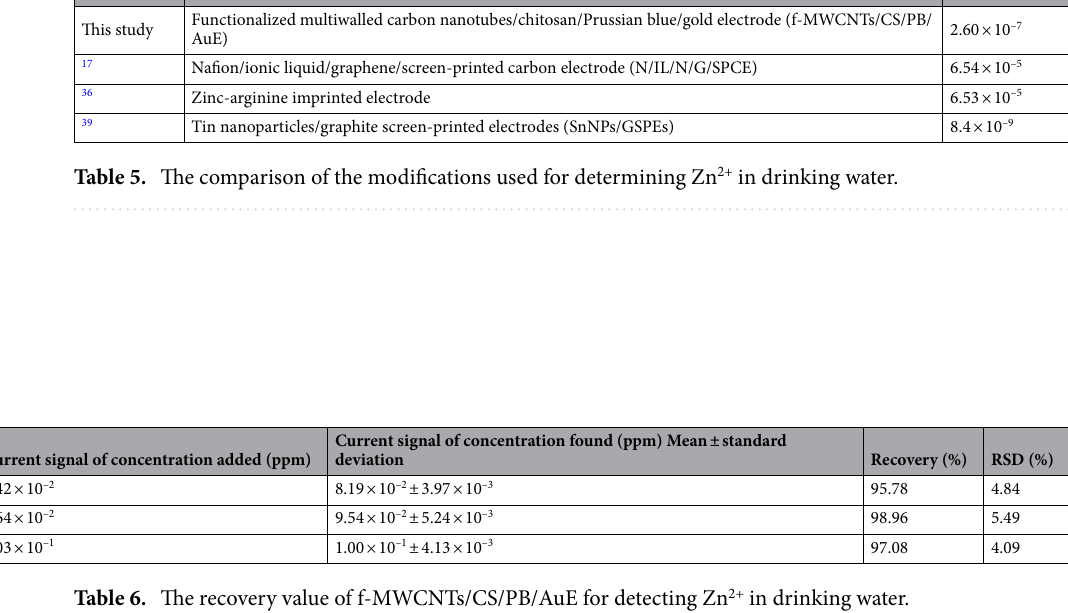
Table 6. The recovery value of f-MWCNTs/CS/PB/AuE for detecting Zn 2+ in drinking water.